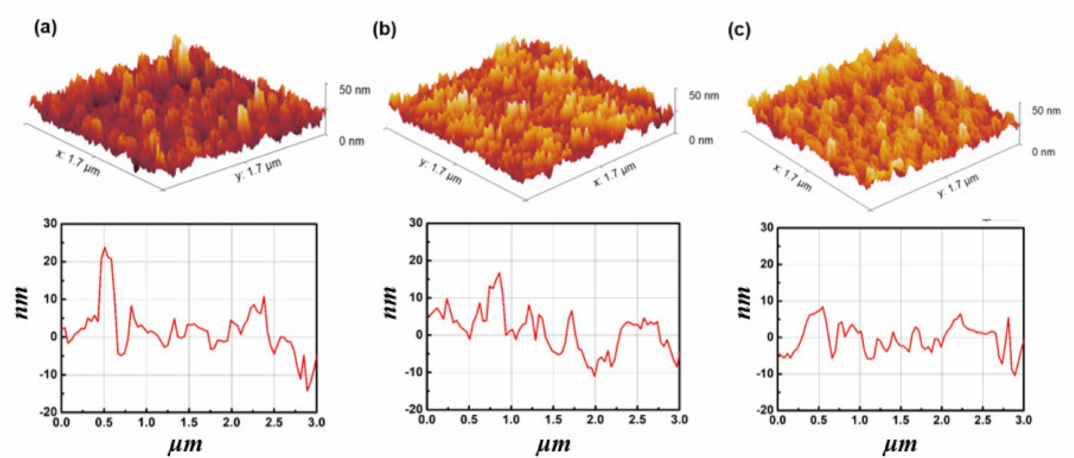
Figure 2. Atomic force microscopy (AFM) images of Ga 2 O 3 films on 4H-SiC wafers at different times of UV/ozone (UV/O 3) exposure: ( a ) non-treated, ( b ) 15 min, and ( c ) 30